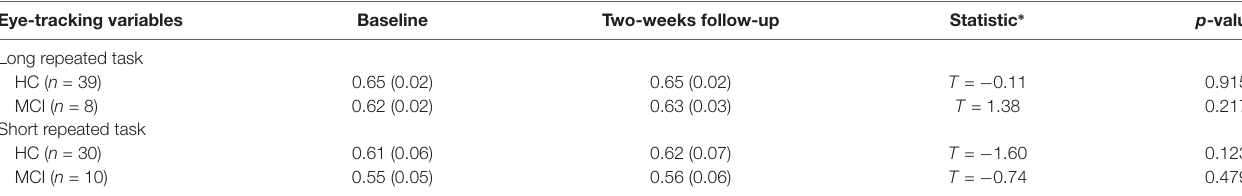
TABLE 3 | Comparison of mean (SD) novelty preferences scores for long repeated and short repeated tasks between patient and controls groups at baseline and at 2-week follow-up using the T -test. Eye-tracking variables